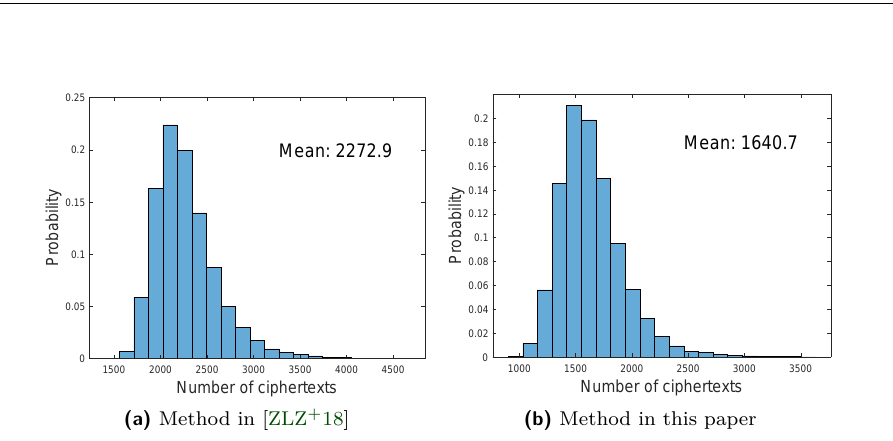
Figure 4: Distribution of N c for c min with 10000